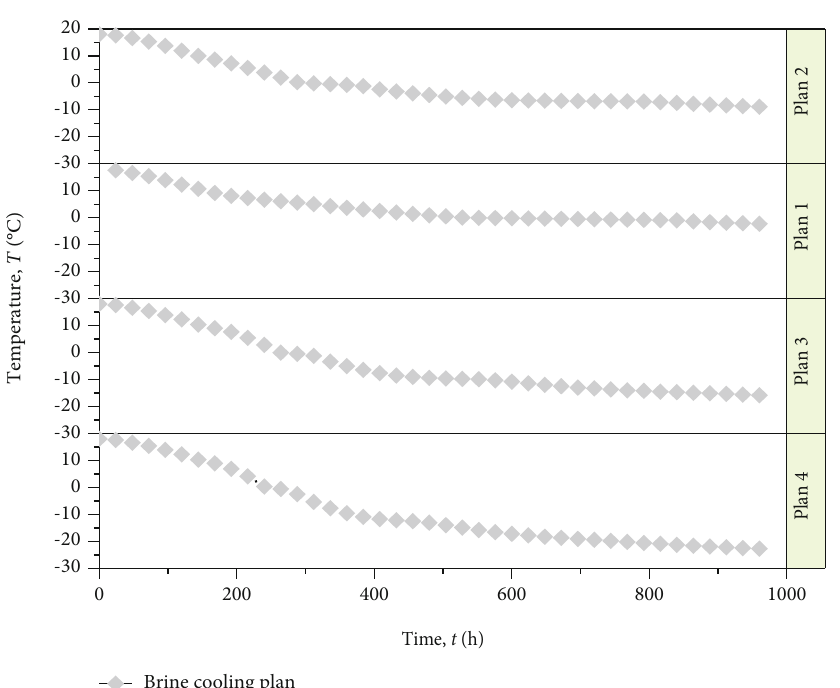
Figure 12: E ff ect of brine cooling plan on temperature fi eld